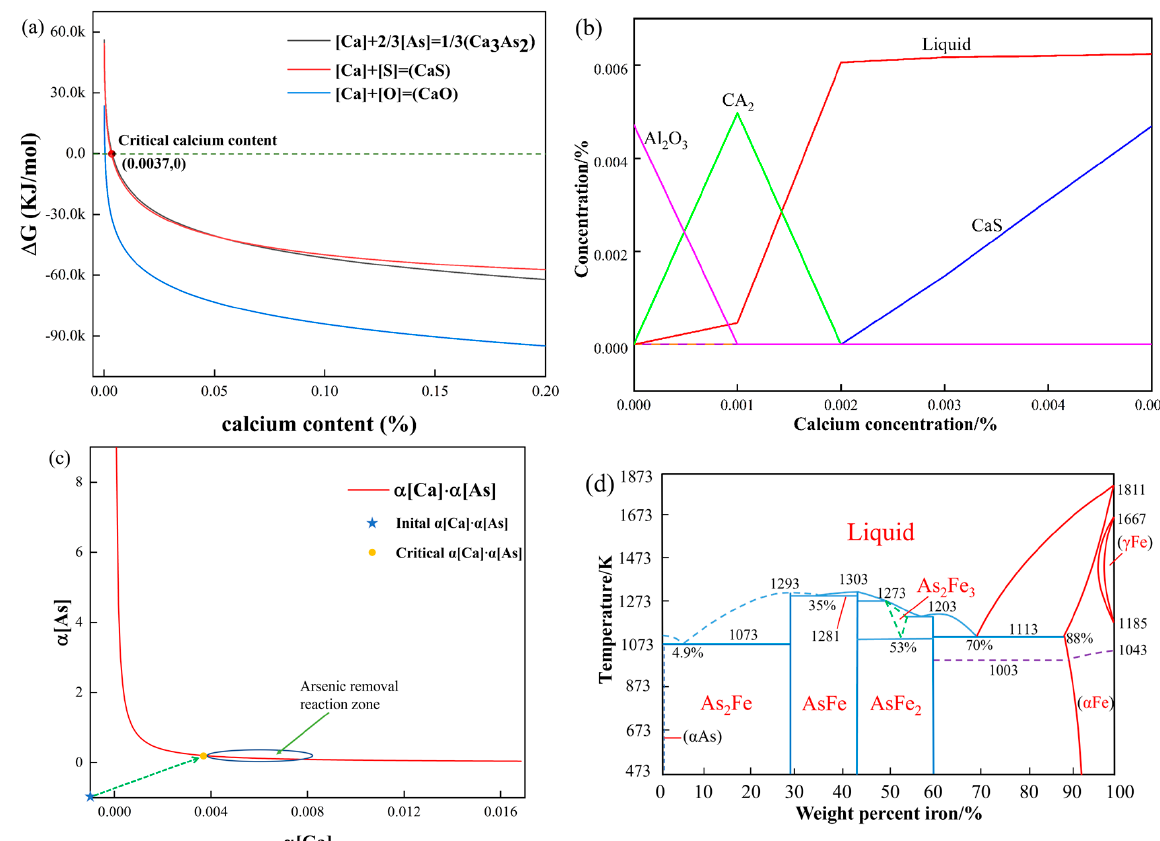
Figure 6. ( a ) Gibbs free energy curve of calcium content; ( b ) effect of Ca Content on inclusion precipitation in liquid steel at 1600 ◦ C; ( c ) calcium-arsenic activity curve; ( d ) Fe-As phase diagram. Due to oxygen and sulfur in molten steel, calcium in molten steel is more likely to react with oxygen and sulfur first, so it is crucial to control the content of oxygen and sulfur